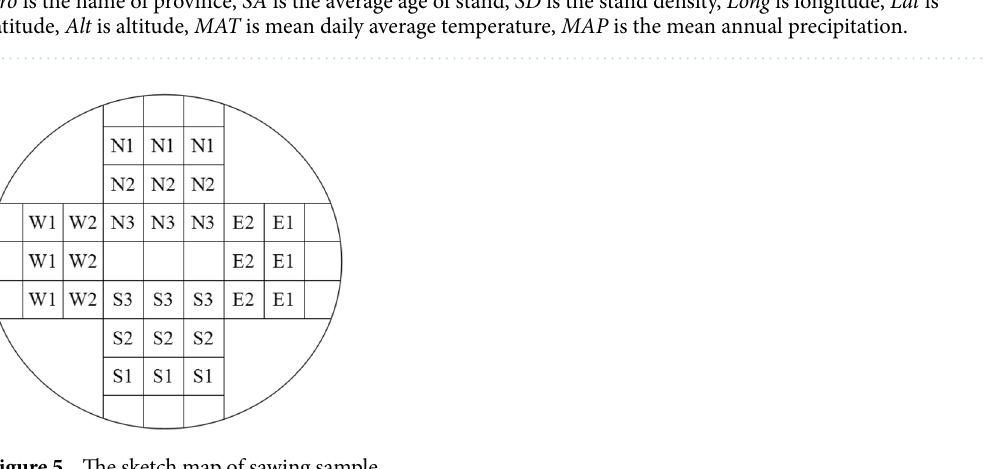
Figure 5. The sketch map of sawing